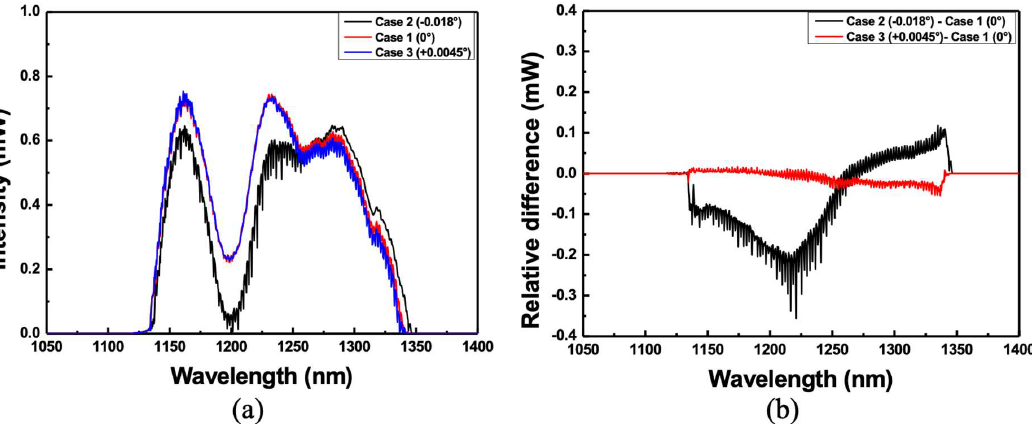
Figure 6. ( a ) Optical spectra on a linear scale for Figure 5, and ( b ) the difference between Case 2 and Case 3 based on Case 1.